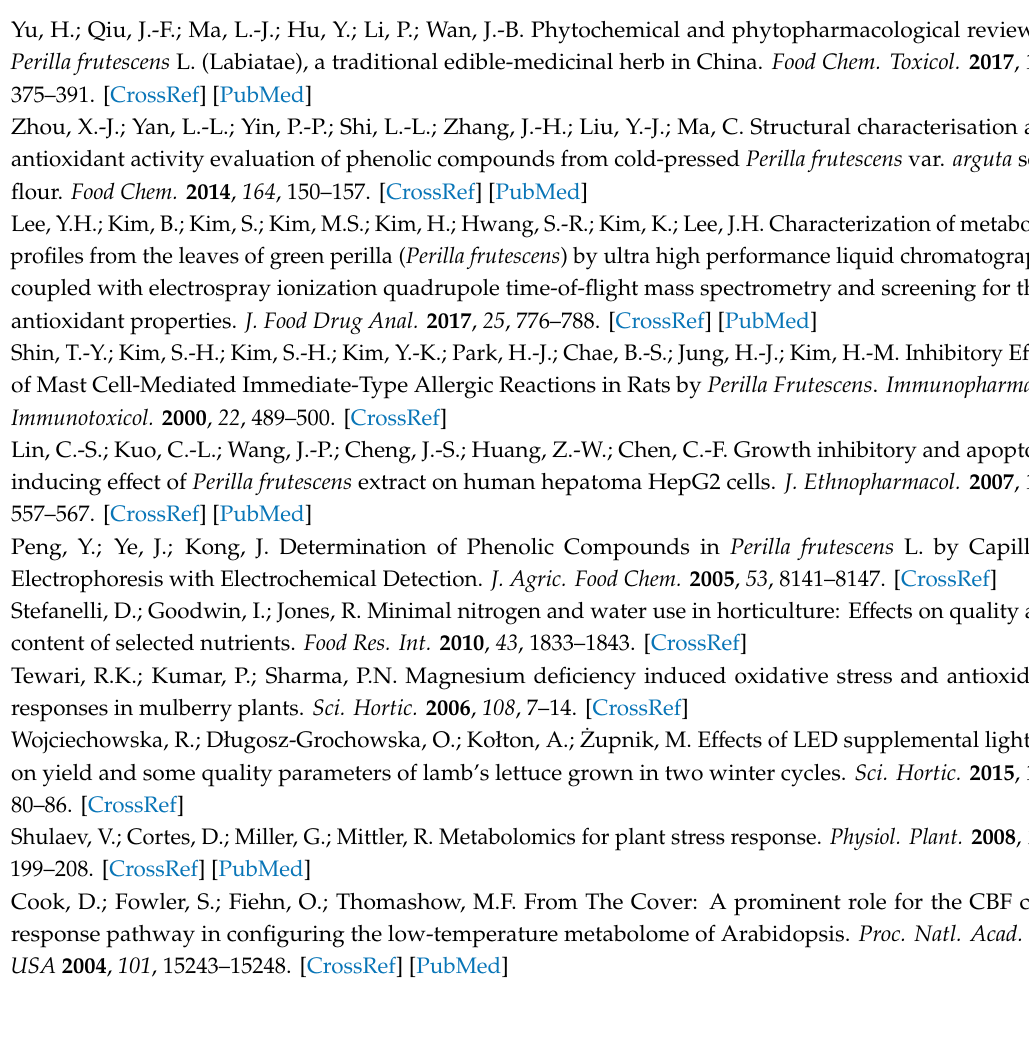
Supplementary Materials: Table S1: Significantly di ff erent primary metabolites of perilla grown under di ff erent mineral nutrient supply conditions and supplemental LED lighting conditions analyzed by GC–TOF-MS, Table S2: Significantly di ff erent secondary metabolites of perilla grown under di ff erent mineral nutrient supply